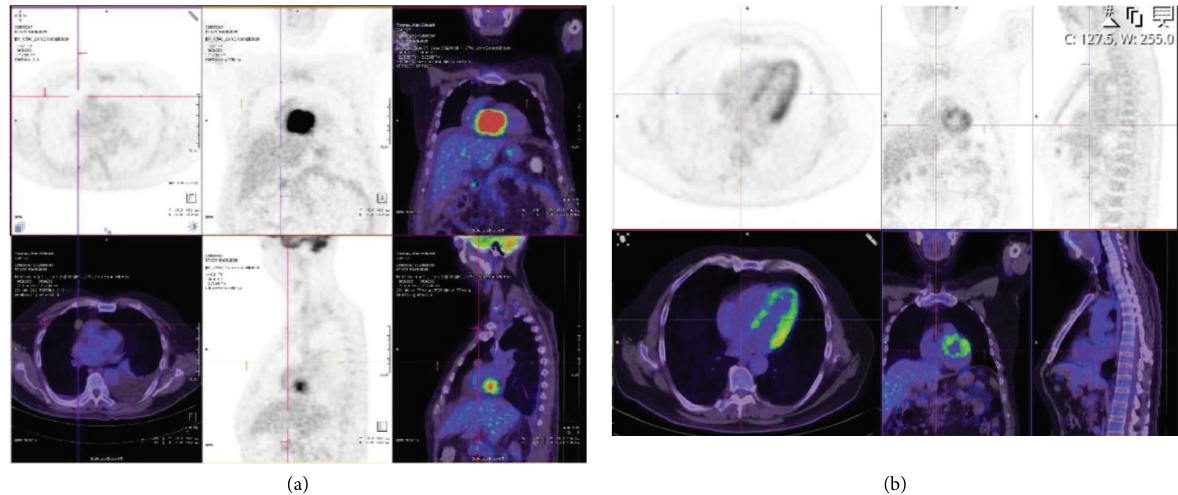
Figure 4: Initial PET (a) demonstrates focal intense FDG uptake corresponding to a right sided cardiac mass (SUVmax 20.6), no longer evident on progress PET (b) in keeping with complete metabolic response. Tere is moderate physiological uptake in the left ventricular myocardium seen in